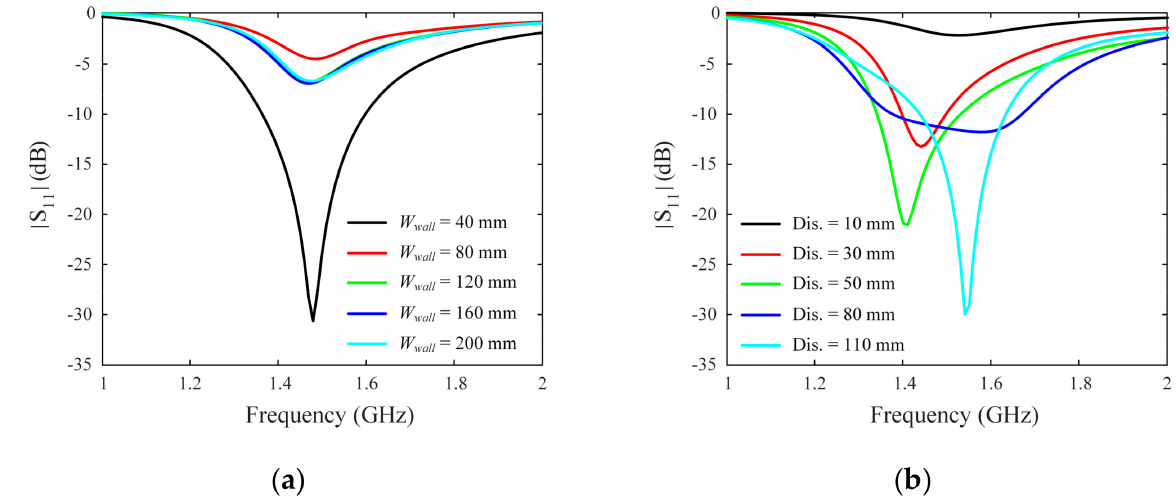
Figure 8. Simulated |S 11 | of the IFA according to ( a ) the metallic wall size (distance = 20 mm) and ( b ) distance ( W wall = 200